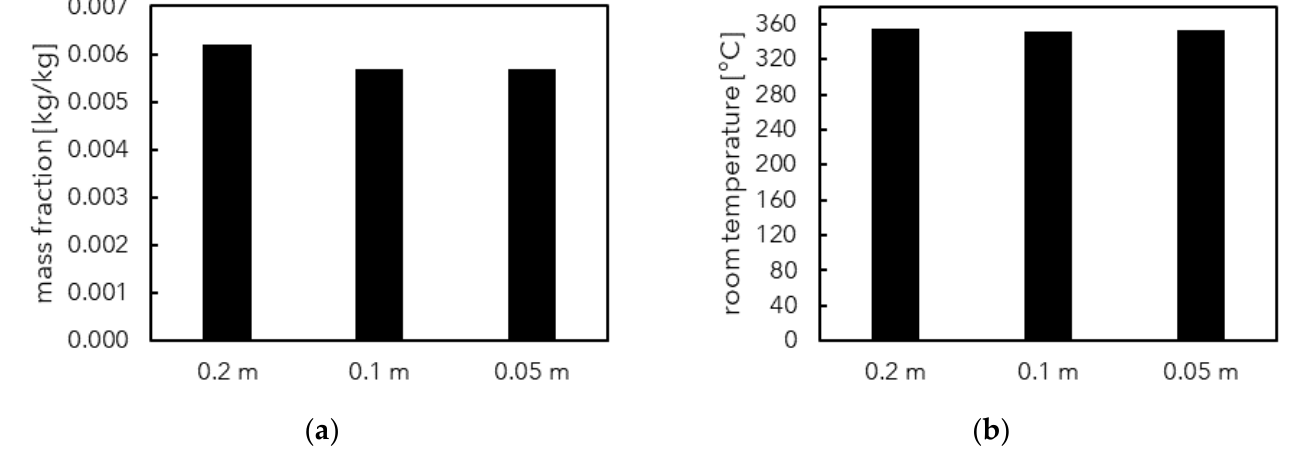
Figure 5. Comparison of results for mesh sensitivity study, measured in the full apartment volume at t = 460 s: ( a ) mean soot mass fraction; and ( b ) mean temperature.